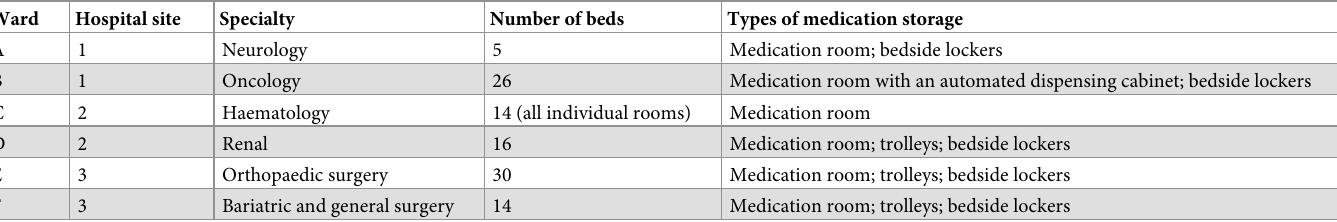
Table 3. The six wards on which observations were conducted and from which staff and patients were recruited for interview. Ward